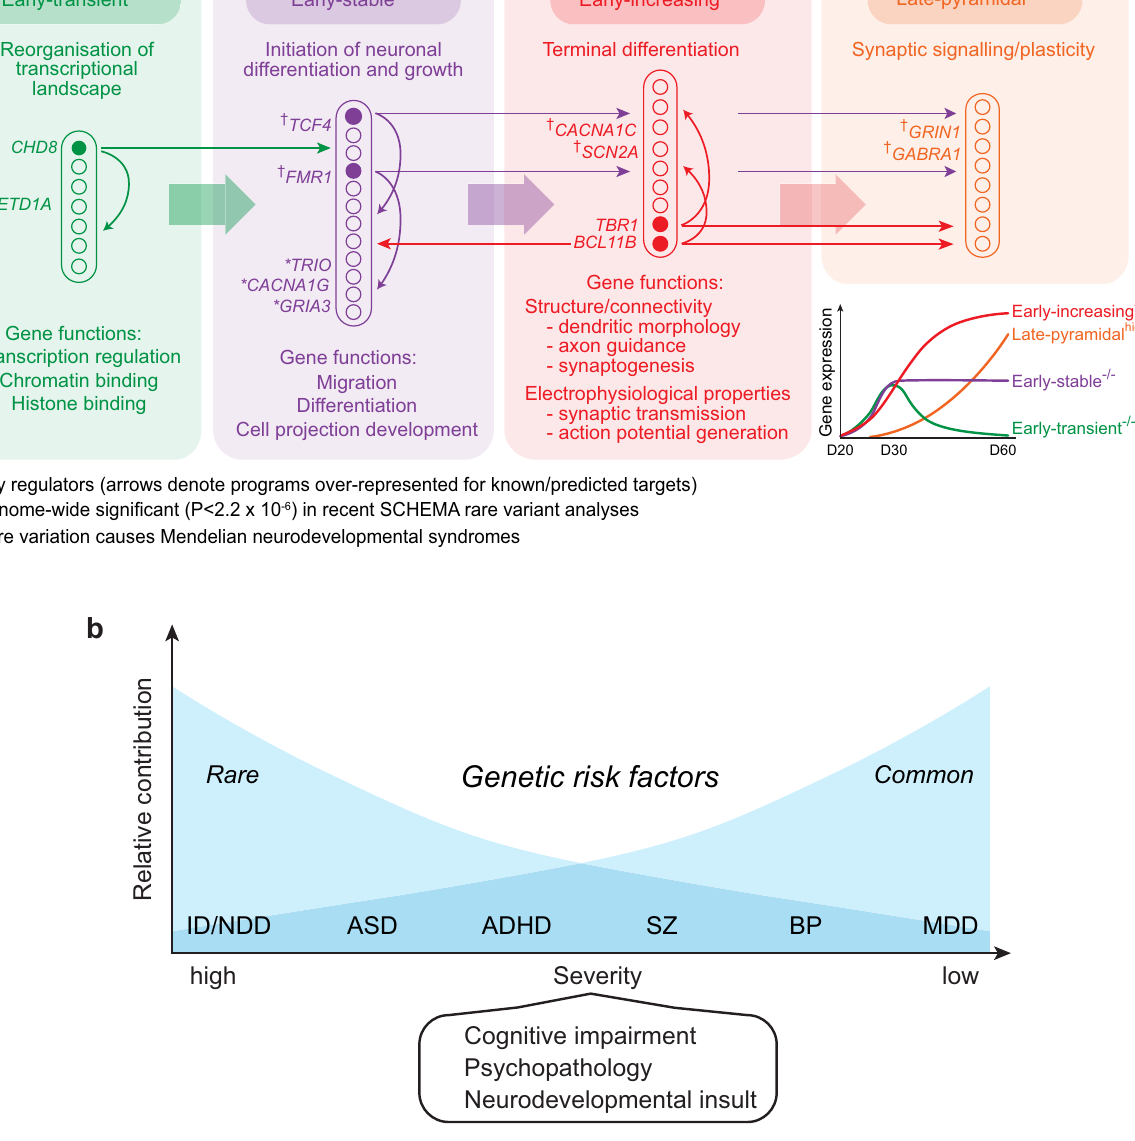
Fig. 8 Model of disease pathophysiology in early corticoneurogenesis. a Summary of main GO term enrichments for each disease-associated transcriptional program (Supplementary Data 7) and signi fi cant regulatory interactions between them. Key regulators, genome-wide signi fi cant rare coding variants from 84 and rare mutations causing Mendelian neurodevelopmental syndromes are denoted. b Neurodevelopmental continuum/gradient model. Disorders shown are: ID/NDD intellectual disability/severe neurodevelopmental delay; ASD autism spectrum disorders; ADHD attention-de fi cit/ hyperactivity disorder; SZ schizophrenia; BP bipolar disorder; MDD major depressive